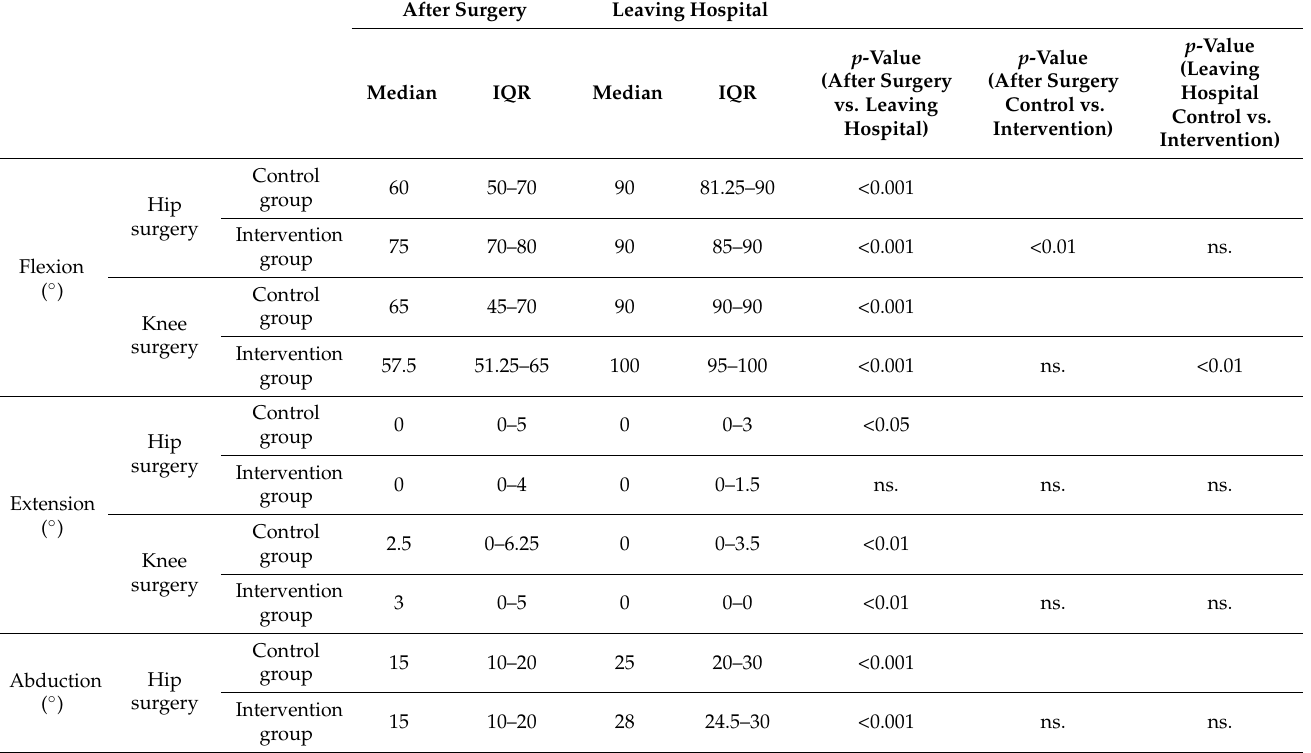
Table 2. Range of motion of the hip and knee joints of endoprosthesis patients. Data on the flexion, extension after hip and knee surgery, and abduction after hip surgery are shown for the control and intervention groups, respectively. ns. = non-significant result. After Surgery Leaving Hospital Median IQR Median IQR